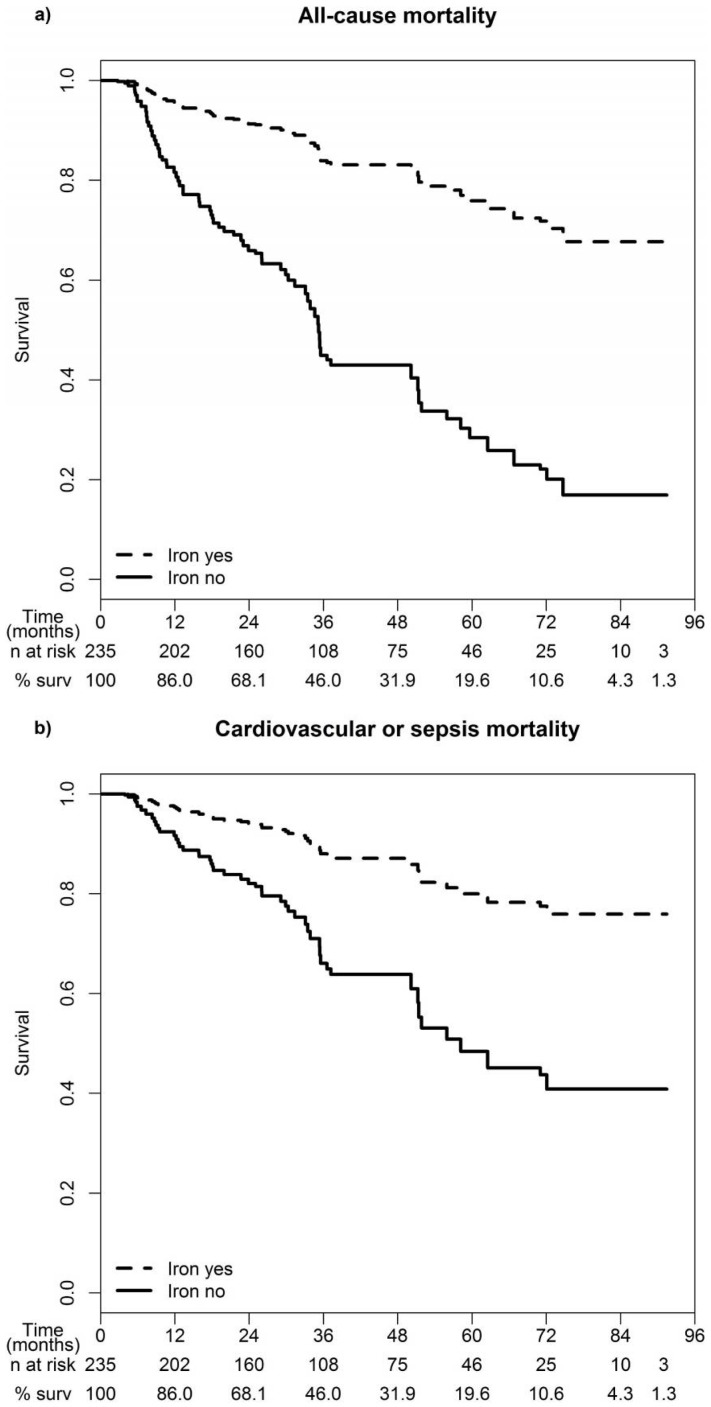
Survival curves for a) all-cause mortality and b) cardiovascular or sepsis-related mortality stratified for iron supplementation.Adjusted for age, sex, time-dependent type of renal replacement therapy, diabetes, time-dependent C-reactive protein, albumin and hemoglobin. The number of patients at risk for each year of observation is given with the last observation time at 91 months. “% surv” indicates the percentage of survivors for each 12-month interval.